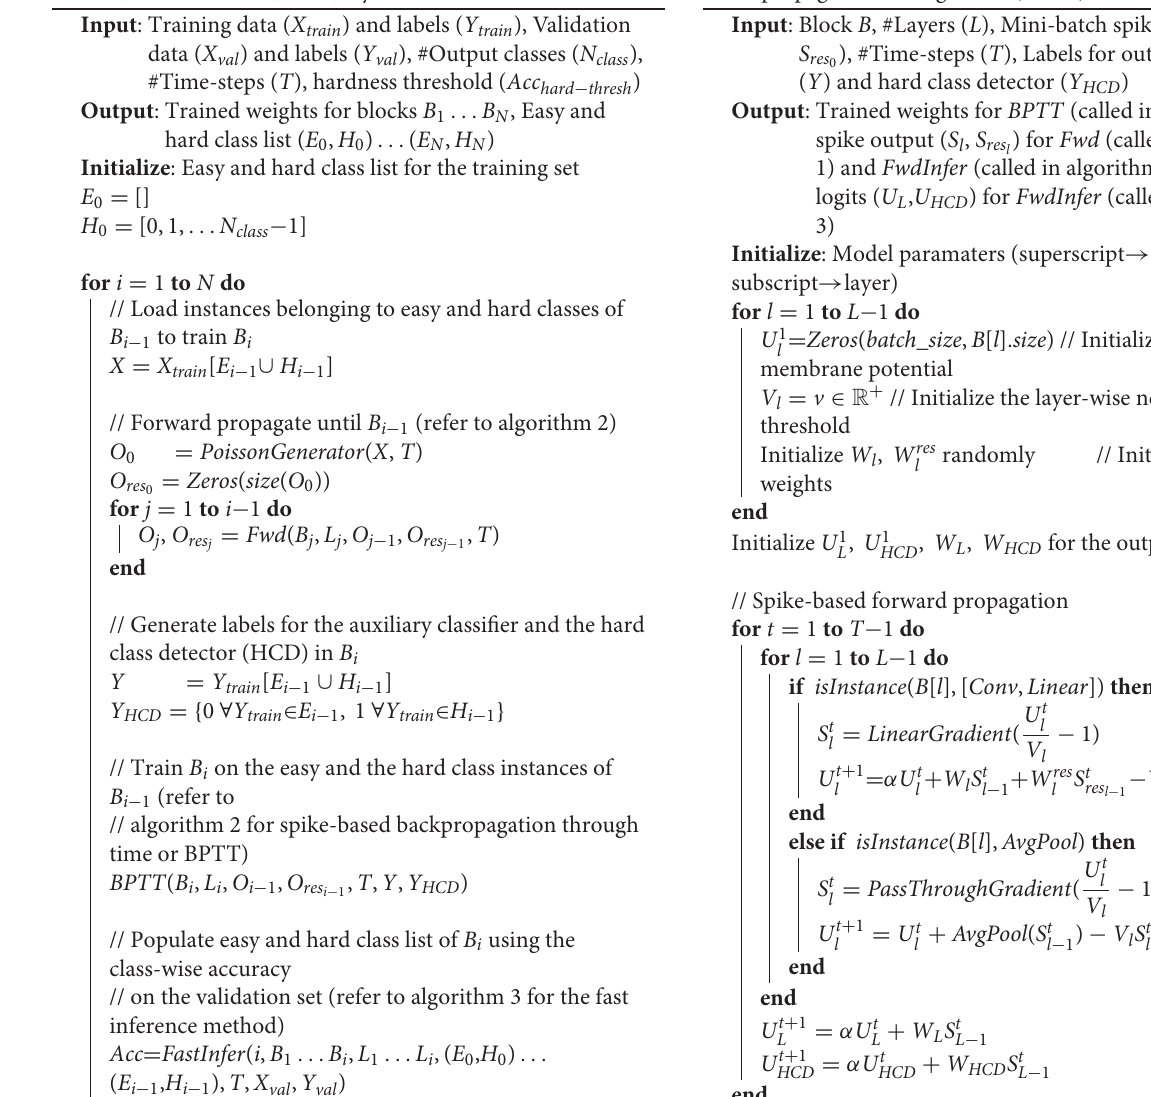
Algorithm 1: Block-wise training for SNN with N blocks B 1 . . . B N , where block B i has L i layers.